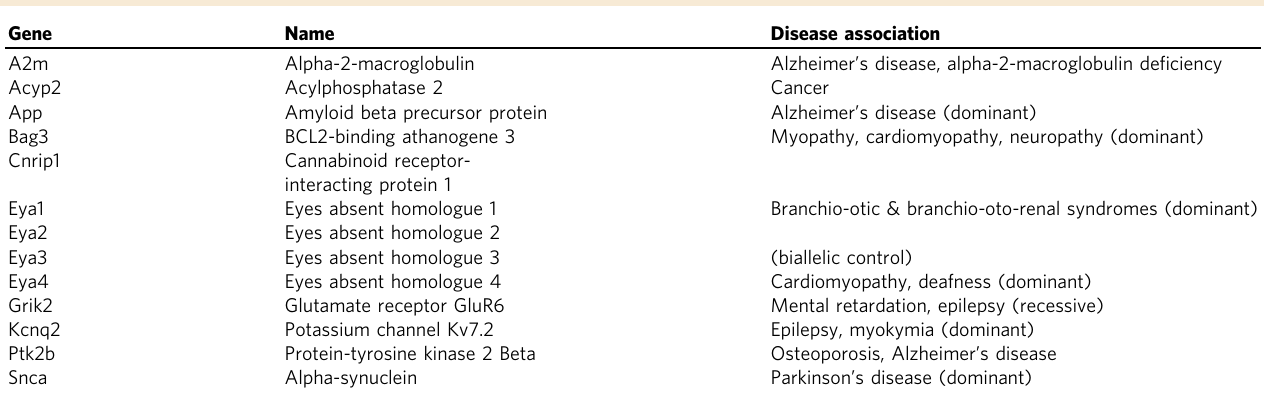
Table 1 Genes of interest, selected from previous genome-wide